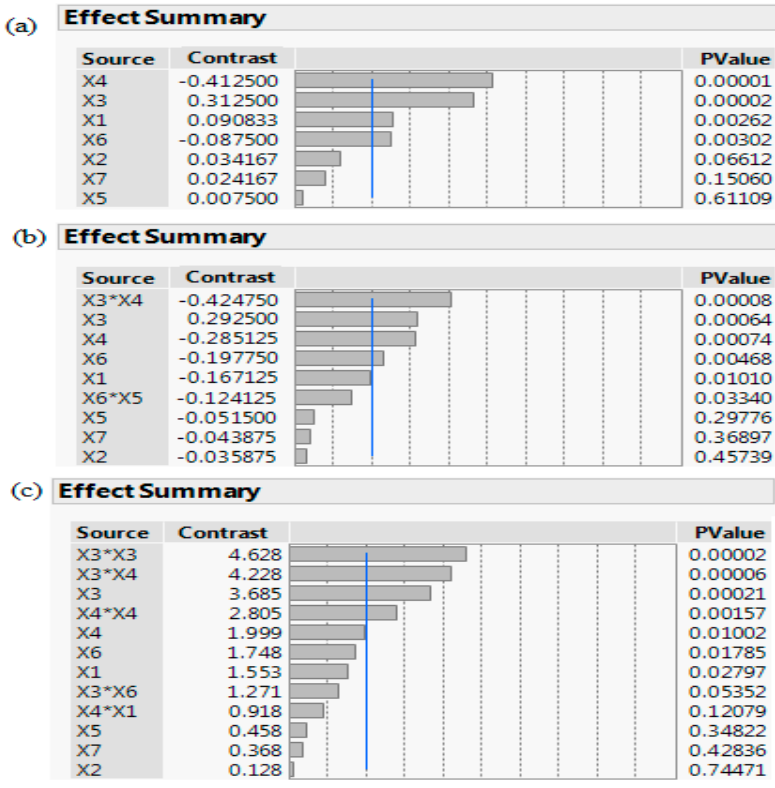
Figure 3. A pareto chart of the screening processes: ( a ) PBD, ( b ) FFD, and ( c ) DSD. The schematic depicts a scaled summary and corresponding p -value of the seven factors: OD (Abs 600 nm ) at induction time (X 1 ), IPTG (X 2 ), temperature (X 3 ), incubation time (X 4 ), yeast extract (X 5 ), tryptone (X 6 ), fructose (X 7 ), along with their interactions. Factors with p -value < 0.05 are statistically significant and variables crossing the reference blue line with p -value < 0.001 are considered as highly statistically significant.